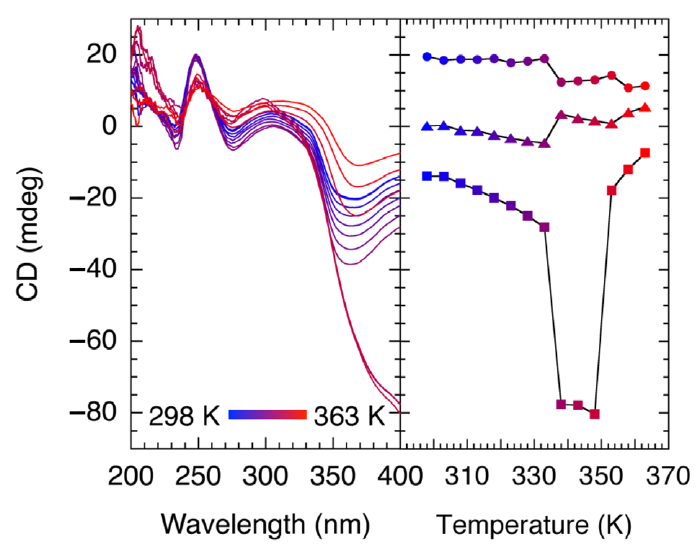
Figure 4. Left: variable temperature CD spectra at 5 K intervals in the temperature range 298–363 K of 1 . Right: temperature dependence of CD ellipticities at 250 (circles), 270 (triangles), and 400 (squares) nm, respectively, for 1 .